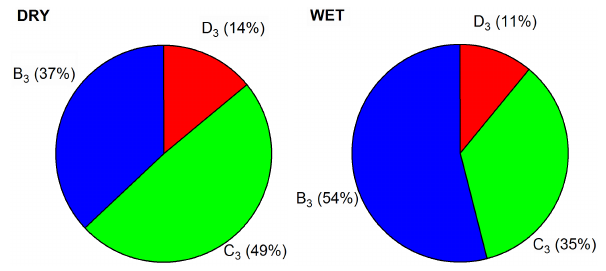
Figure 7. WIBS-3 fluorescent cluster fractions B 3 , C 3 and D 3 ob- served during dry (left) and wet (right) Fig. 7. WIBS-3 fluorescent cluster fractions B 3 , C 3 and D 3 ob-